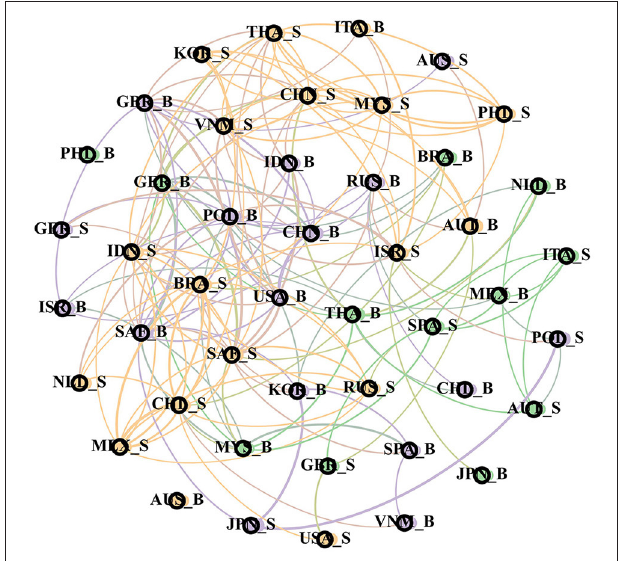
FIGURE 7 | Risk network structure during the global spread of COVID-19